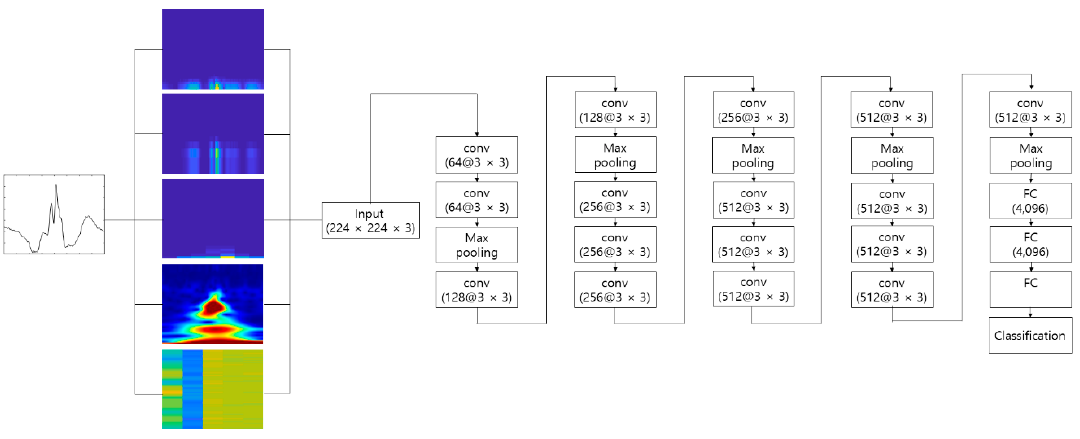
Figure 1. Structure of VGGNet with the time-frequency representations as inputs.